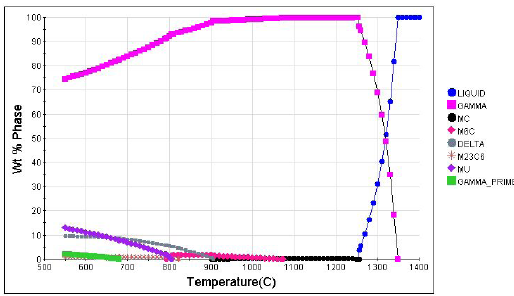
Figure 1. Thermodynamic simulation of phase fraction (wt. %) as a function of temperature for Inconel 625 superalloy. Table 1. Simulation of the phases (wt. %) as a function of aging temperature for Inconel 625 superalloy. Temperature (ºC) → Phases ↓